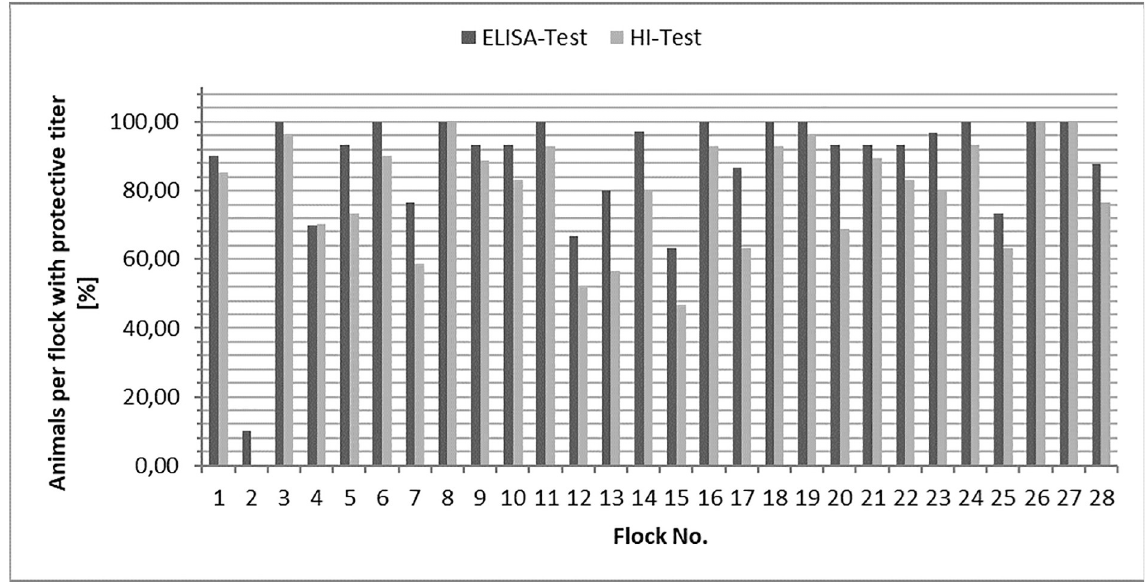
Fig 1. Proportion of animals with protective titer in ELISA and HI